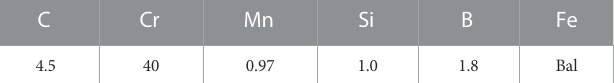
TABLE 1 Chemical composition of iron-based alloy powder (mass fraction, %).